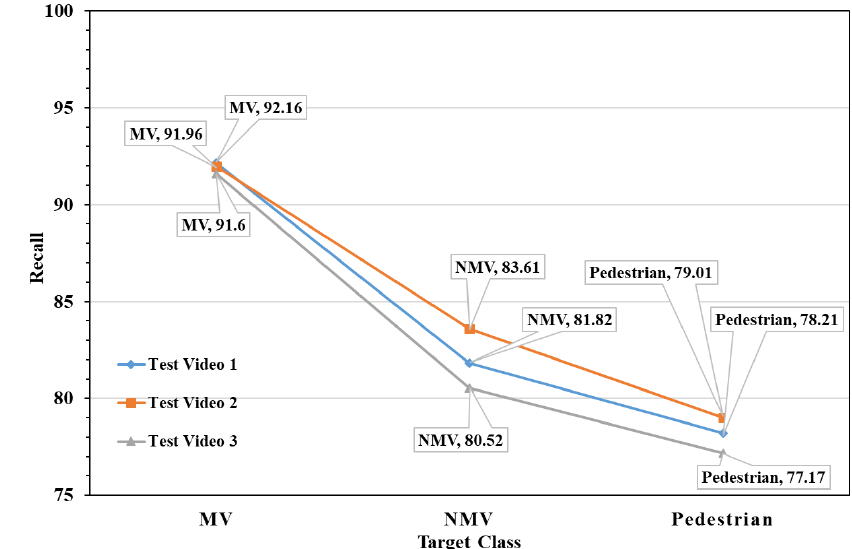
Figure 7. Recall calculation of target classes on three captured test